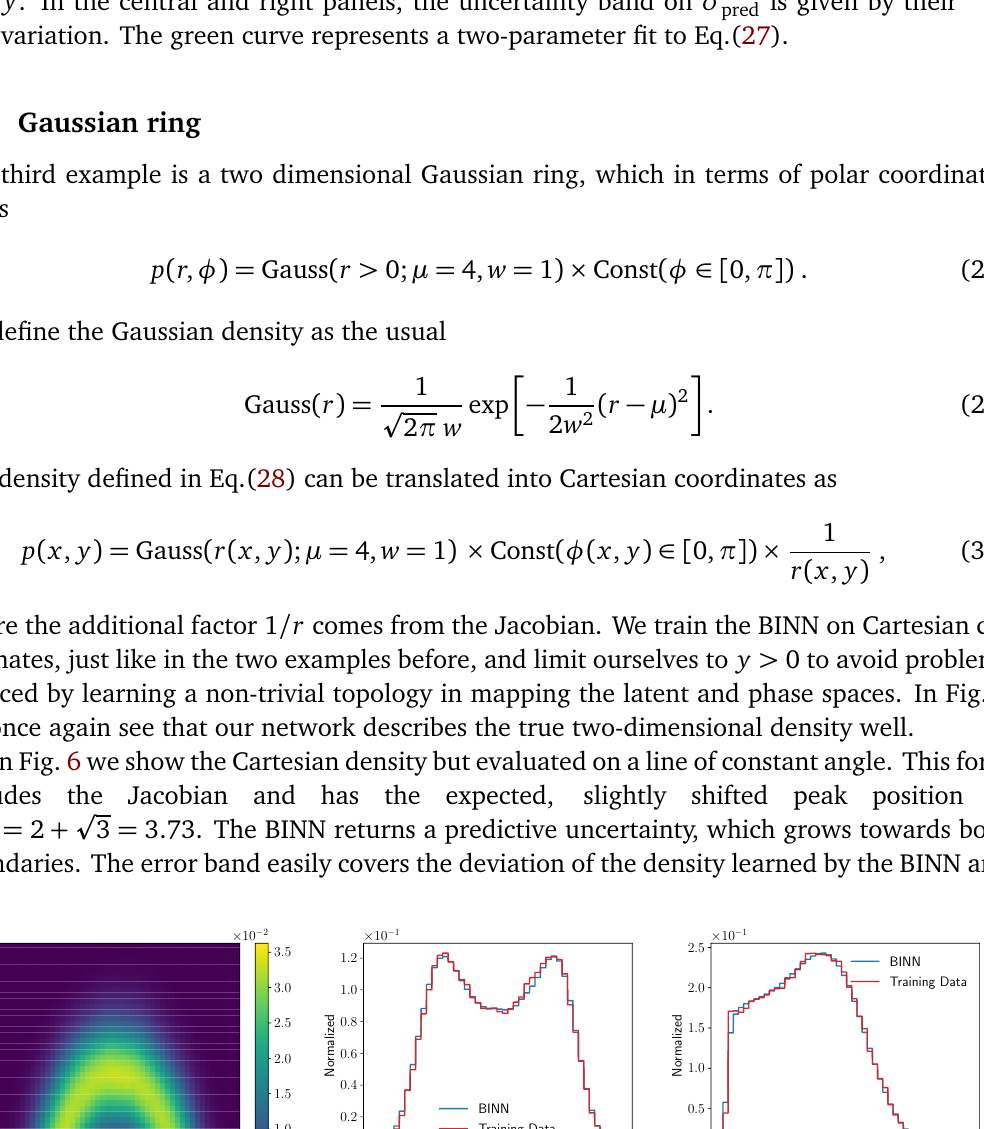
is given by their pred